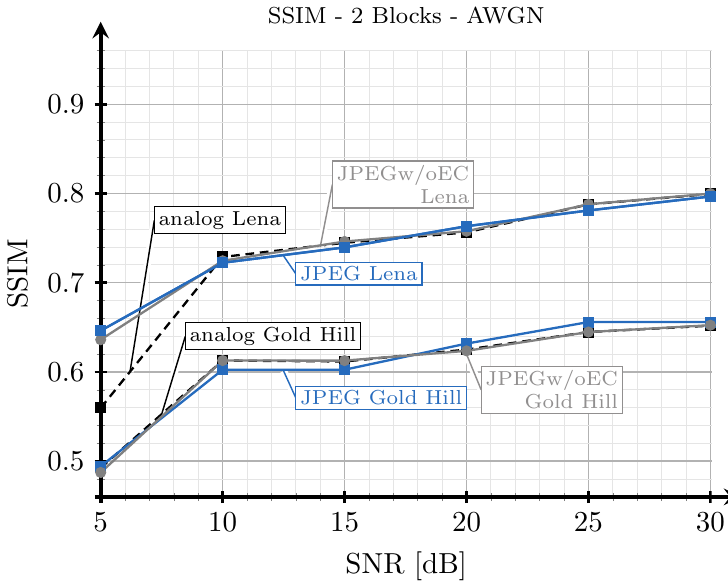
Figure 15. SSIM vs. SNR for two blocks and AWGN channel.